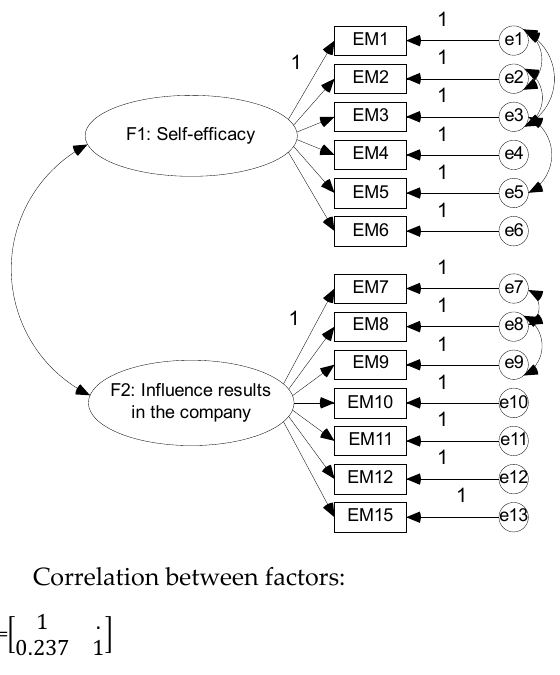
Figure 1. Model 1, single factor.